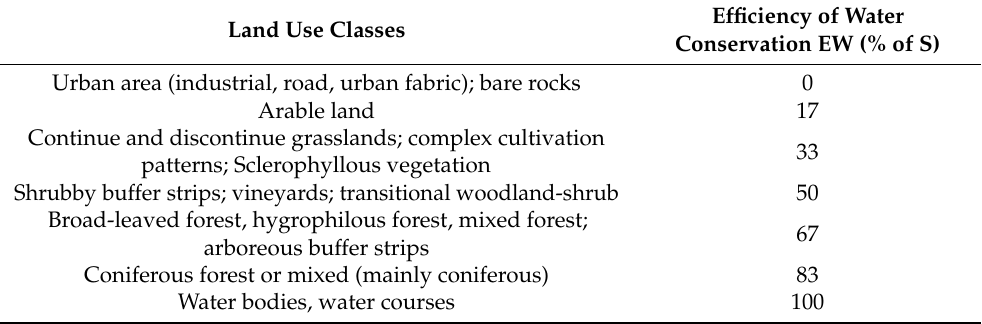
Table 1. Efficiency of water conservation provided by different land use classes (derived from Humann et al. [60] for forest and elaborated from Nedkkov and Burkhard [61] for the other land use